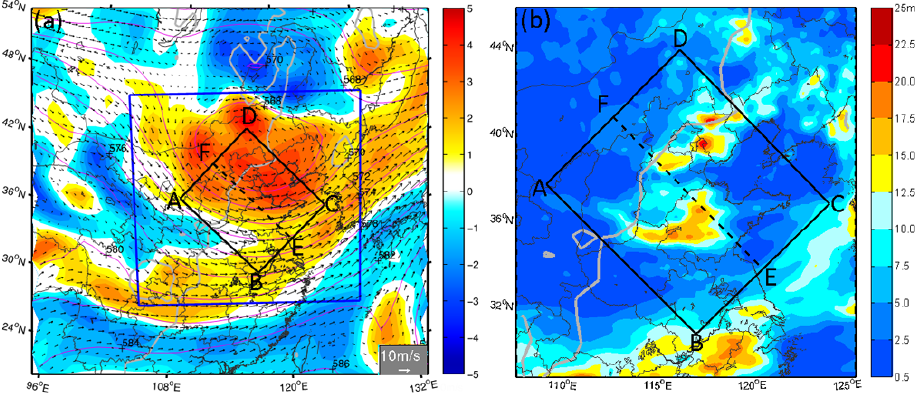
Fig. 2. (a) The average 500hPa relative vorticity (10 − 5 s − 1 , shaded), horizontal wind vectors, and geopotential height every 2dam (magenta contours) between 00:00UT on 17 June and 00:00UT on 24 June 2004 from GFS analysis. The blue box is the simulation domain. The rectangle ABCD indicates the focus area, and the dashed line EF divides ABCD into north and south domains. (b) Average daily precipitation (mm) between 17 and 24 June from